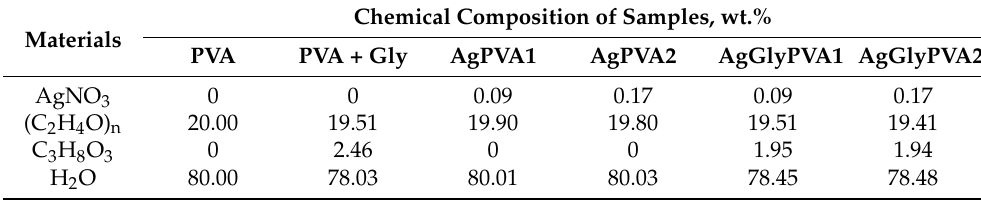
Table 1. Chemical composition of experimental PVA gels.